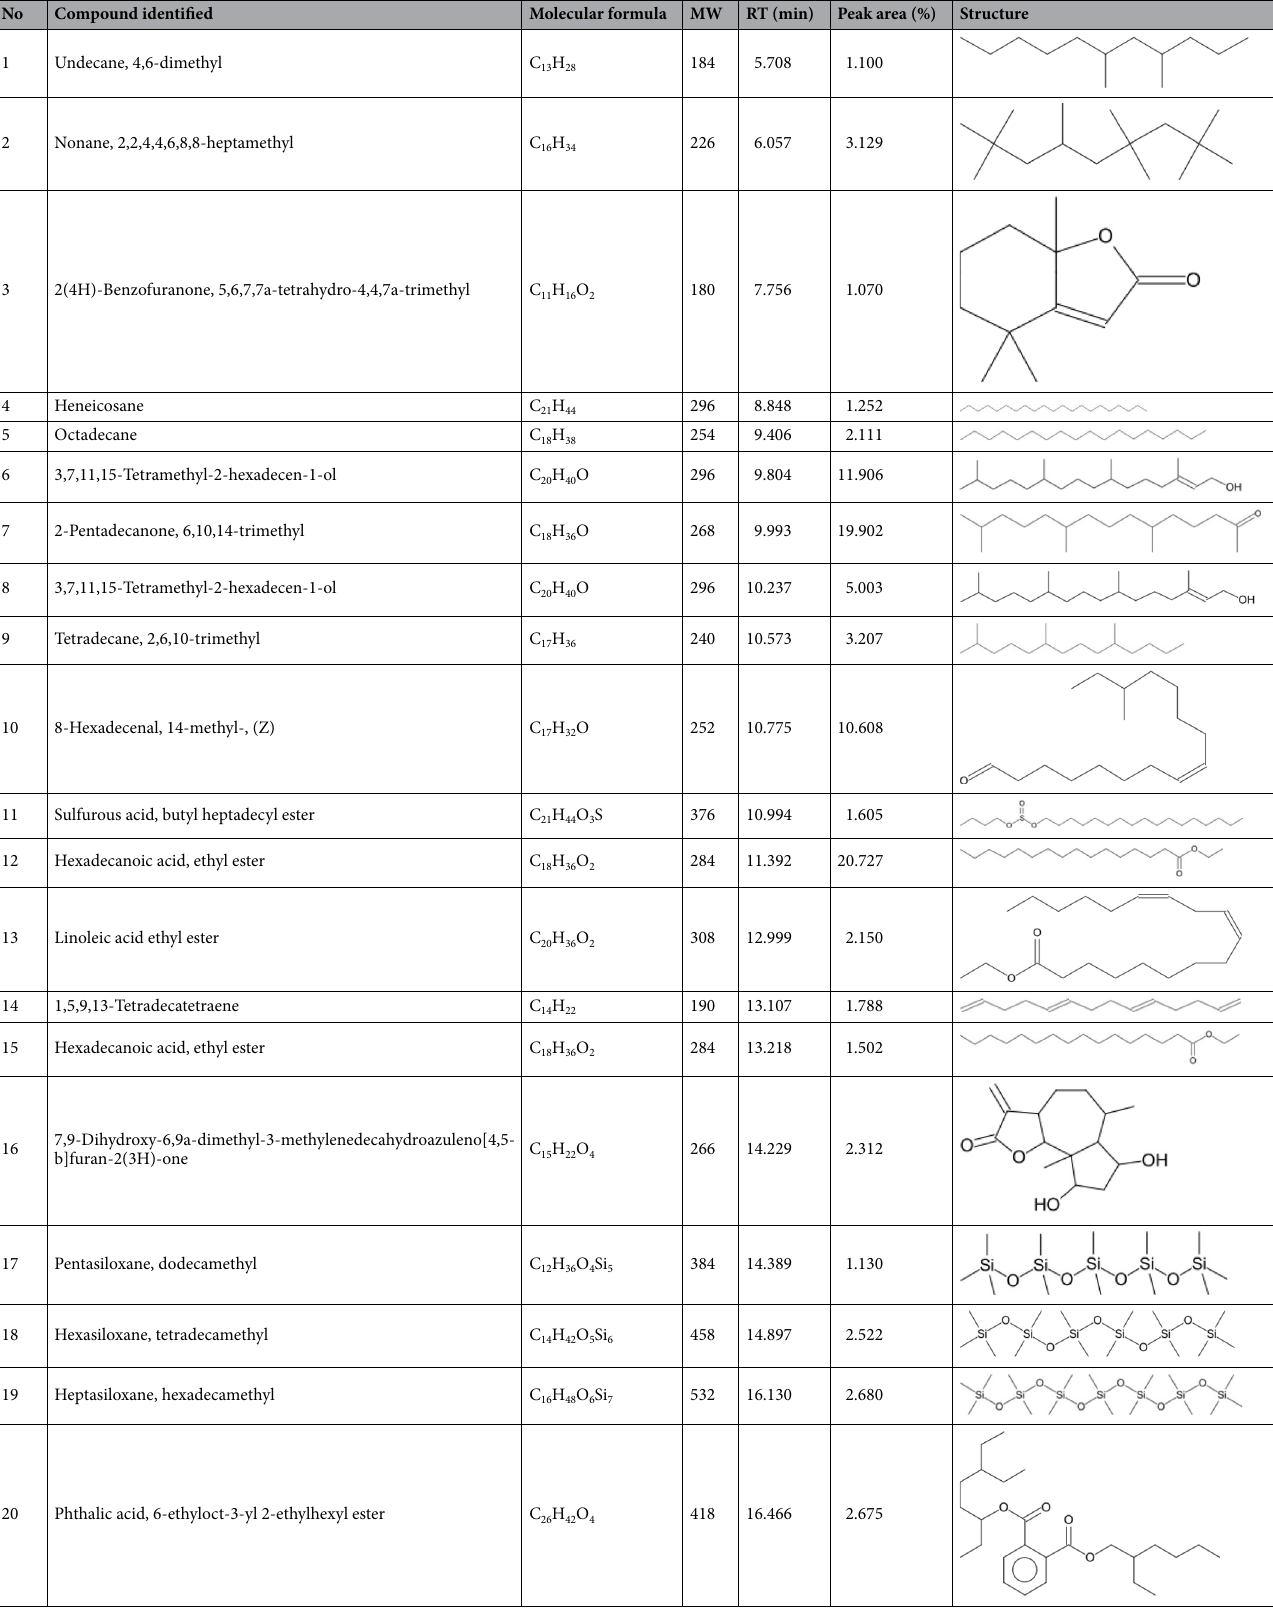
Table 3. GC–MS analysis of T. cherleri